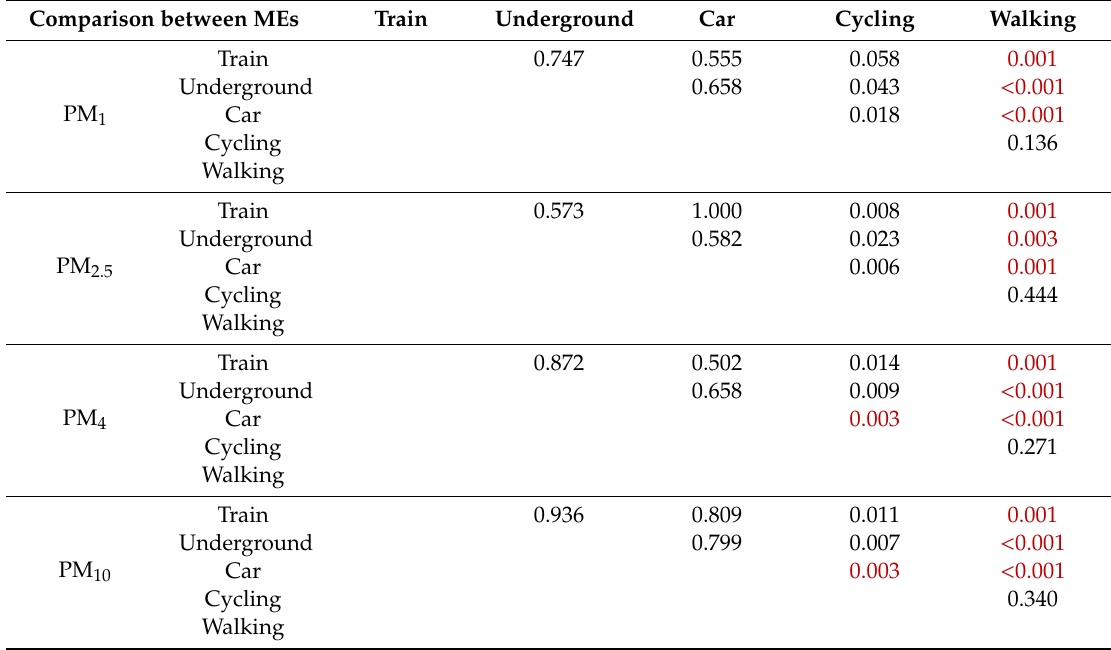
Table 5. Mann–Whitney U test significance values. p values of < 0.005 are highlighted in red. Comparison between